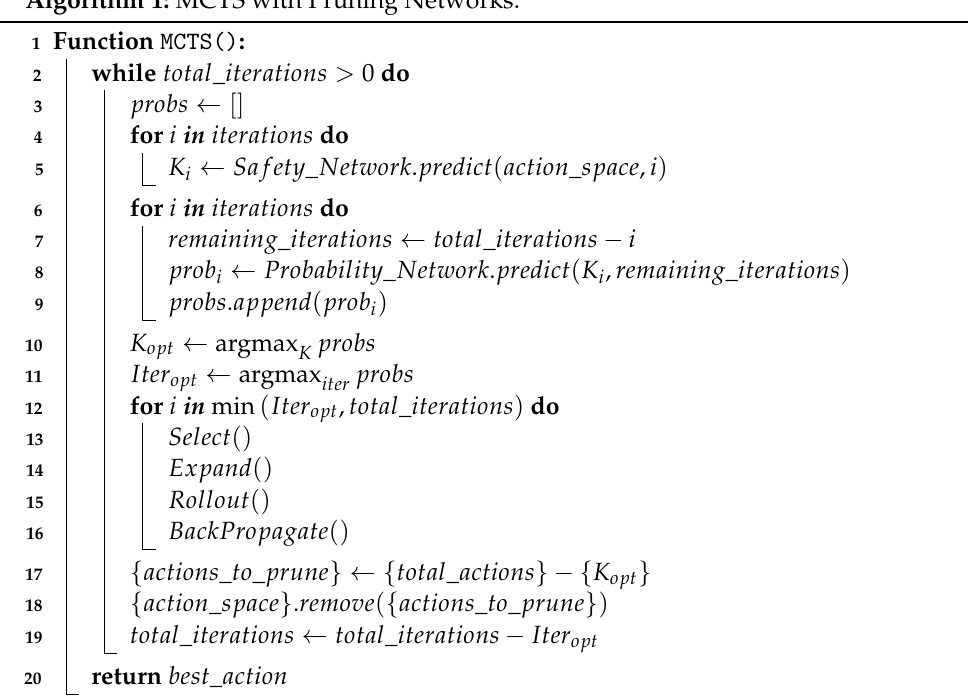
Algorithm 1: MCTS with Pruning